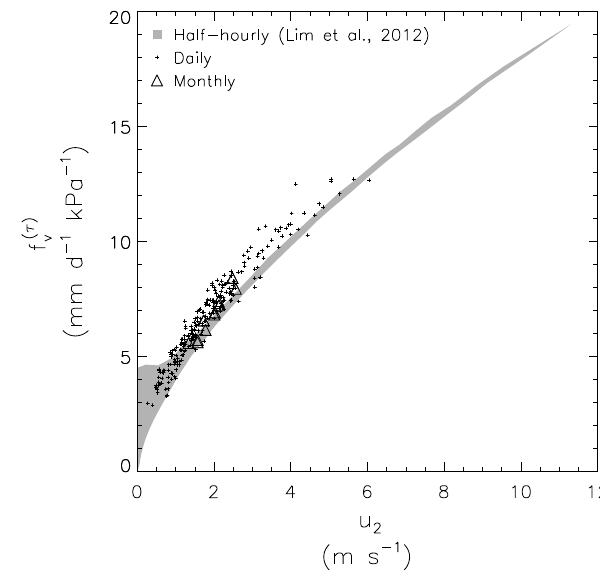
Fig. 5. Estimates of the aerodynamic function f (τ) v versus u 2 (wind speed at 2ma.g.l.) for the experimental pan for different integration periods.